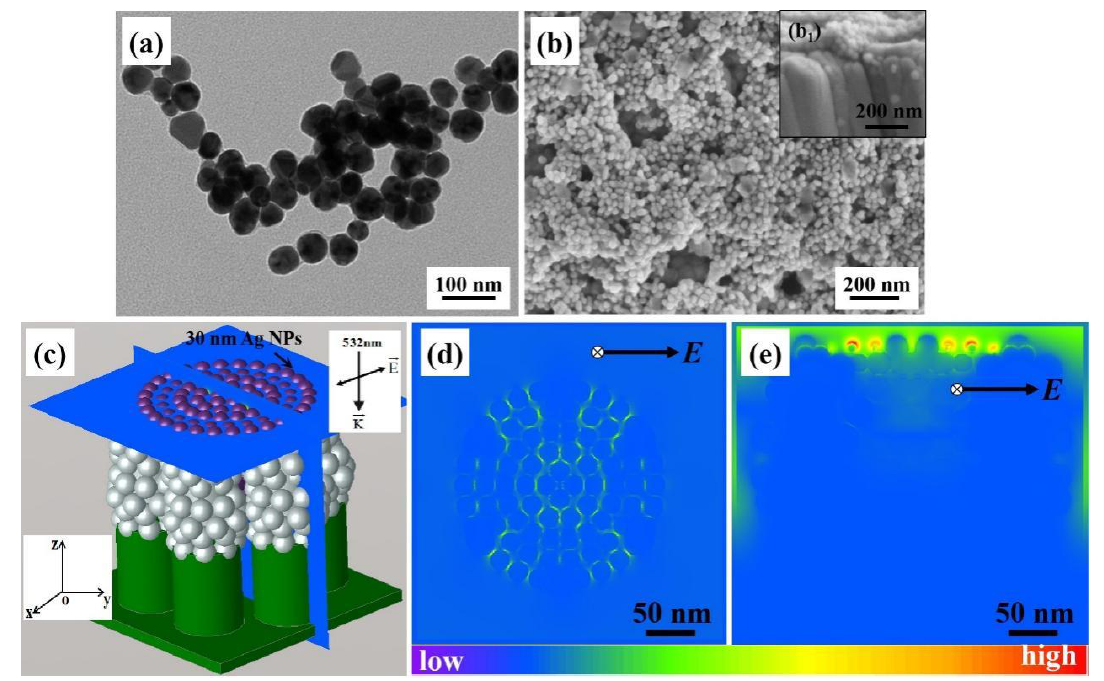
Figure 6. ( a ) TEM image of the Ag NPs; ( b , b 1 ) top view and cross-section view FE-SEM images of the Ag NPs 30 -Ag 20 -AAO substrate; ( c ) 3D-FDTD model of the Ag NPs 30 -Ag 20 -AAO nanoarray; the spatial distributions of the electromagnetic field intensity of the Ag NPs 30 -Ag 20 -AAO nanoarray in the ( d ) x-y plane and ( e ) y-z plane.